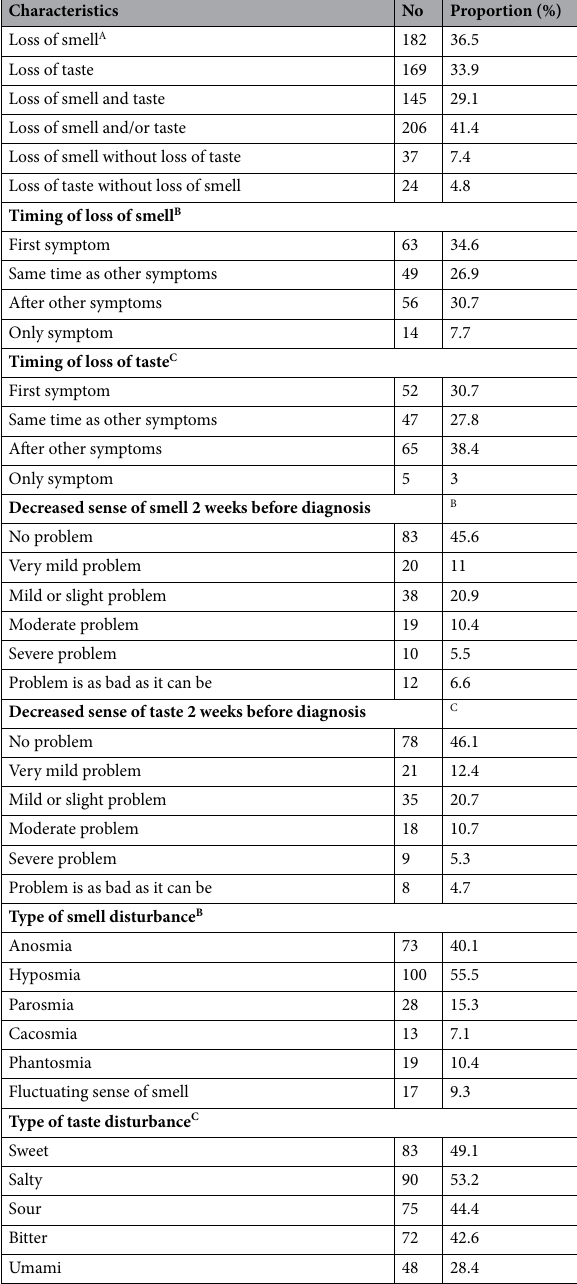
Table 2. Characteristics of olfactory and taste disturbances in COVID-19 patients. A Calculated as a proportion of total number of patients (N = 498). B Calculated as a proportion of total number of patients with loss of smell (n = 182). C Calculated as a proportion of total number of patients with loss of taste (n =